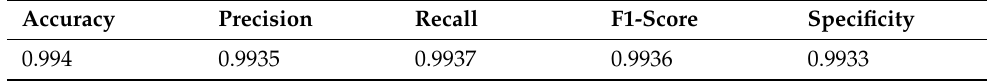
Table 7. The performance measurements of ConvXGB on another